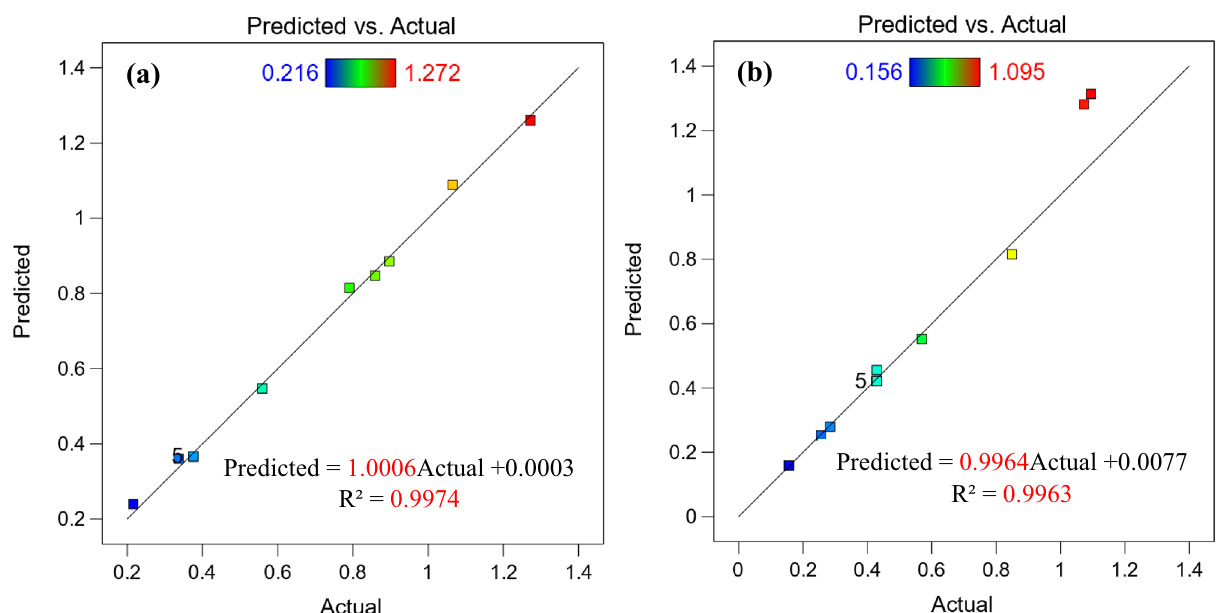
Figure 5. Relationship between actual and predicted wear rate ( a ) hot-rolled and ( b ) QAM f